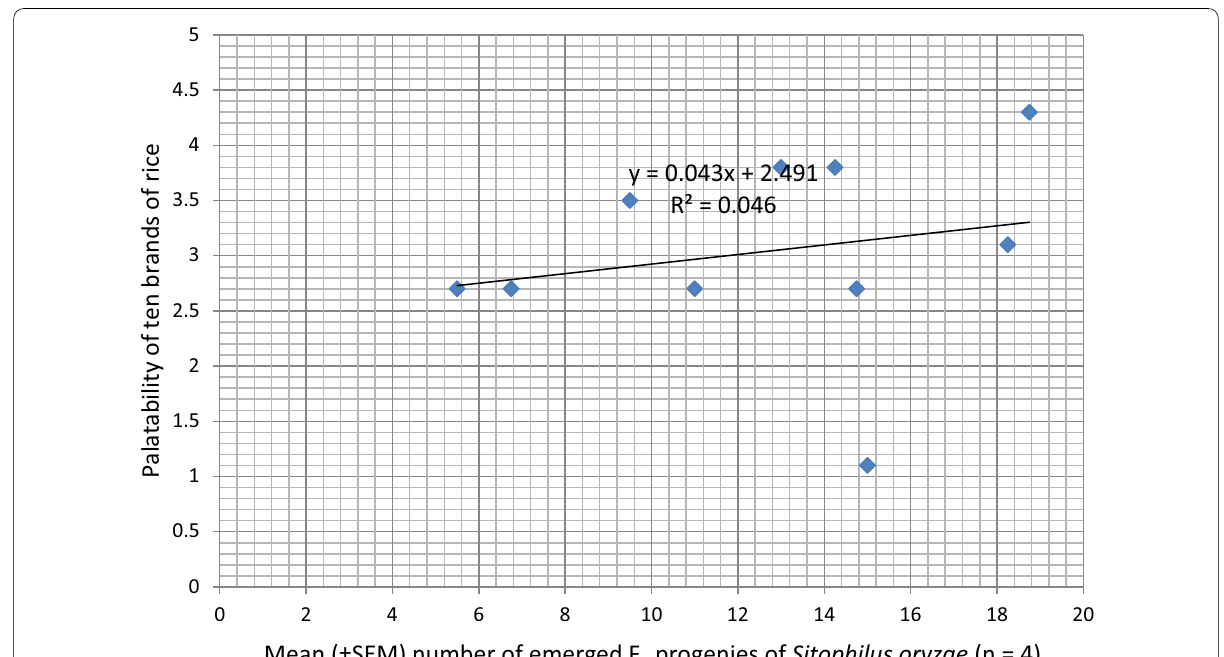
Fig. 1 Association between rice brand palatability and number of F 1 progenies of Sitophilus